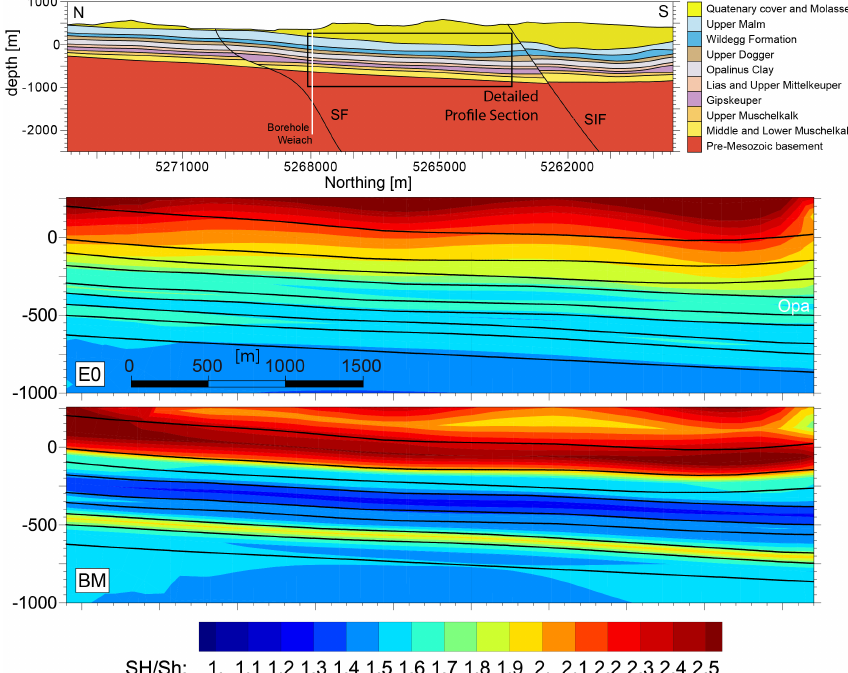
Figure 14. Detailed view of S H /S h ratio in north–south cross sections through the Weiach well for different Young’s moduli. Geomechanical stratification for reference (top), homogeneous model E0 (middle) and base model BM (bottom) with rock properties as defined in Table